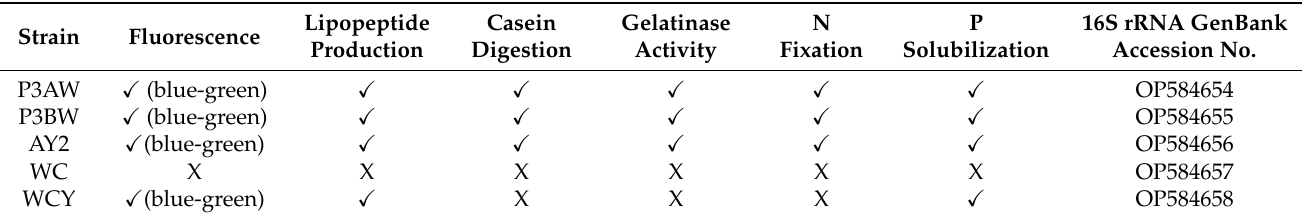
Table 2. Strains of endophytic bacteria isolated from A. palmeri , their characteristics, and GenBank accession numbers.